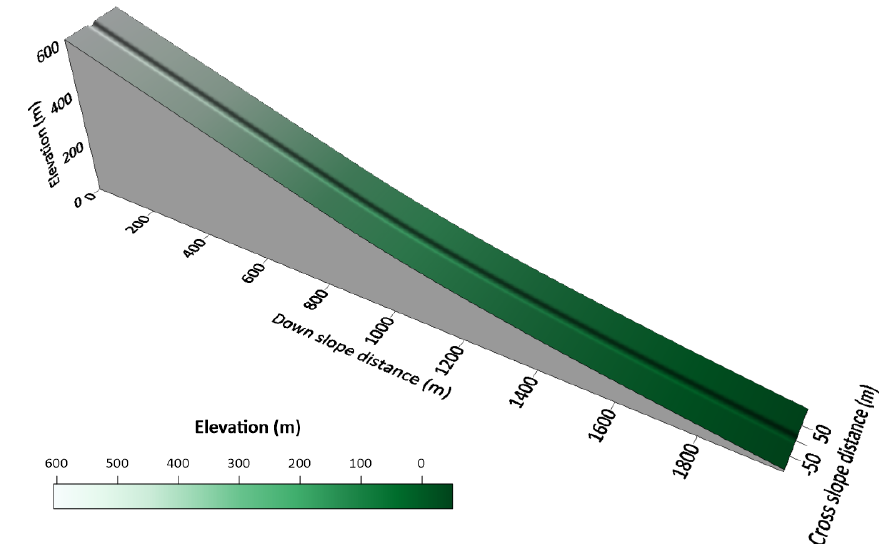
Figure 2. Idealized channel topography used for numerical